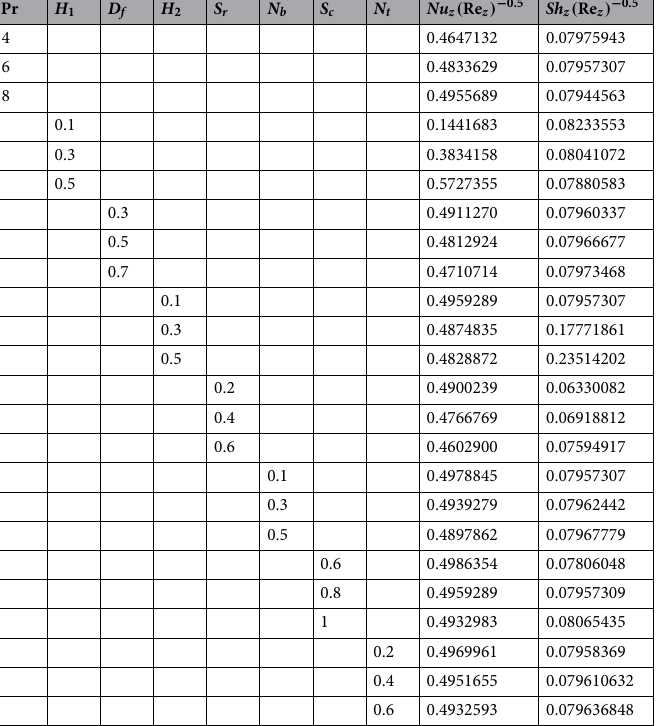
Table 3. Computational values of Nu z ( Re z ) − 0.5 and Sh z ( Re z ) − 0.5 against the different estimation of Pr, H 1 ,